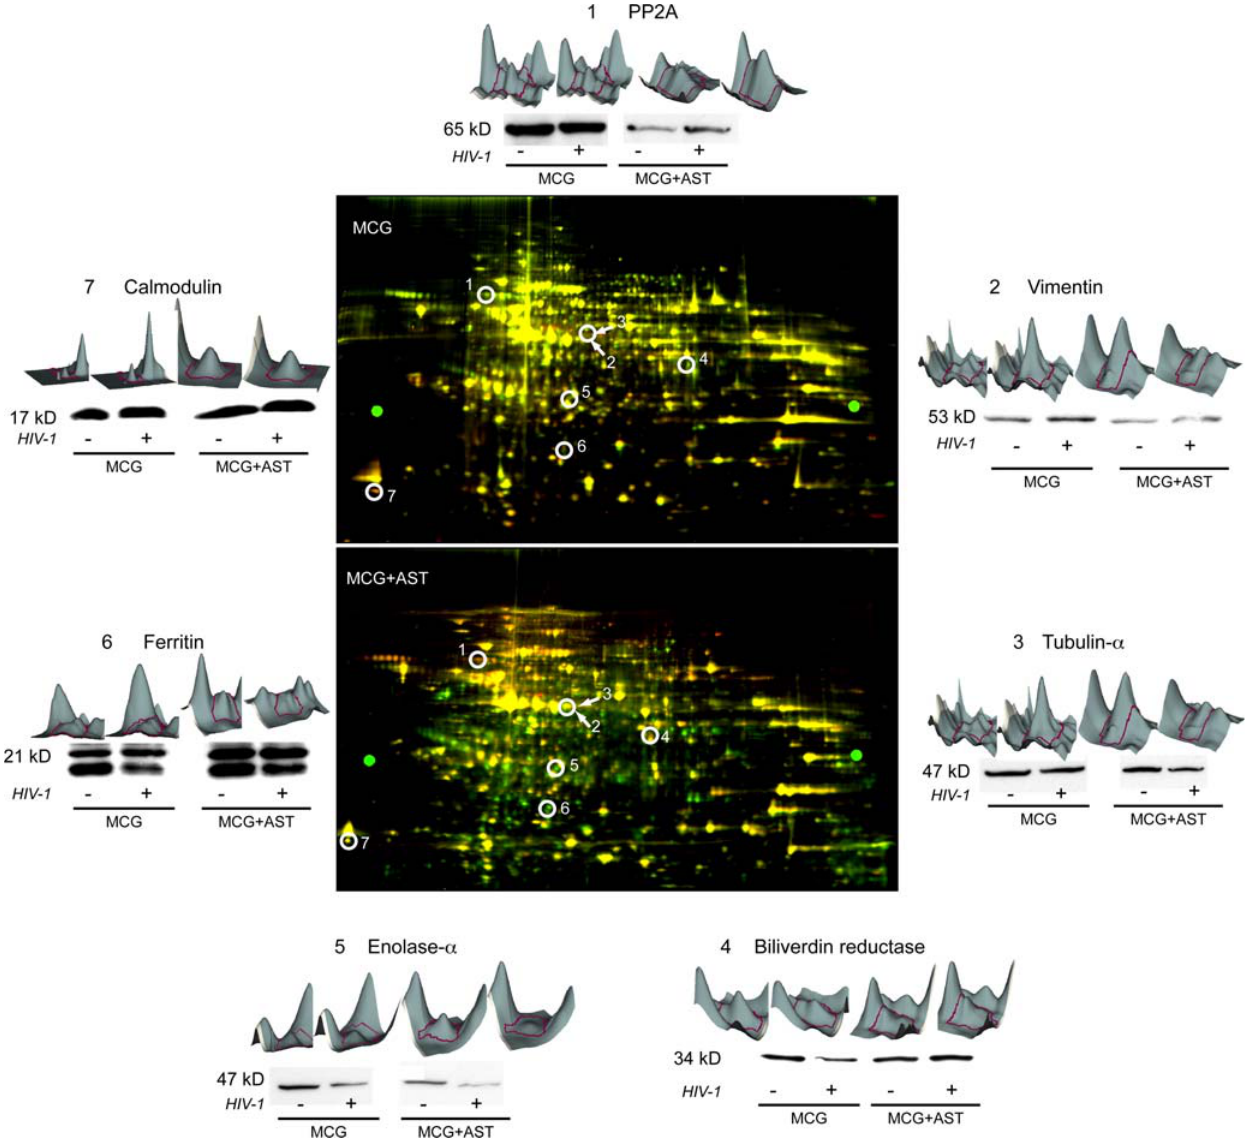
Figure 2. Proteome of HIV-1/VSV infected microglia (MCG) and MCG co-cultured with astrocytes (AST). DiGE analyses of lysates of uninfected and HIV-1/VSV infected microglia cultured alone (MCG, upper gel) or in the presence of astrocytes (MCG + AST, lower gel) Proteins from uninfected microglia lysates are labeled with Cy3 (green), whereas those from HIV-1/VSV infected microglia are labeled with Cy5 (red). After merging, proteins exhibiting no changes appear yellow in the DiGE image, down-regulated proteins in green, and up-regulated proteins in red. Three- dimensional DeCyder interpretation for seven representative proteins identified by mass spectrometry and corresponding Western blot analysis are shown around the DiGE images. Each pair of protein spots (Cy3-and Cy5-labeled) are 3D views of their relative peak volumes. The peak area comprising the entire volume represents the distribution of the protein spot in the gel, whereas the volume correlates to the protein concentration. The consecutive numbers of spots located in the respective DiGE images correspond to the protein volumes shown.